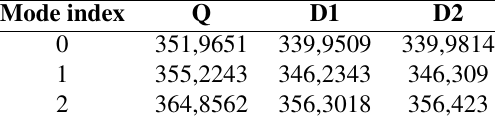
Table 4. Frequency spectrum of the RFQ (in MHz), computed from FEM simulations of the whole